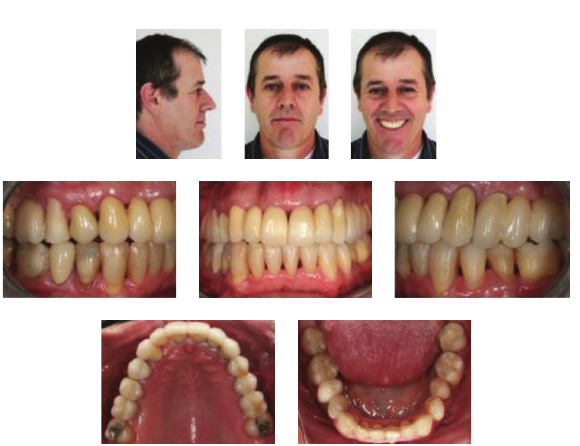
Figure 7: Posttreatment facial photographs and intraoral pho- tographs 1 year and 11 months after debonding.